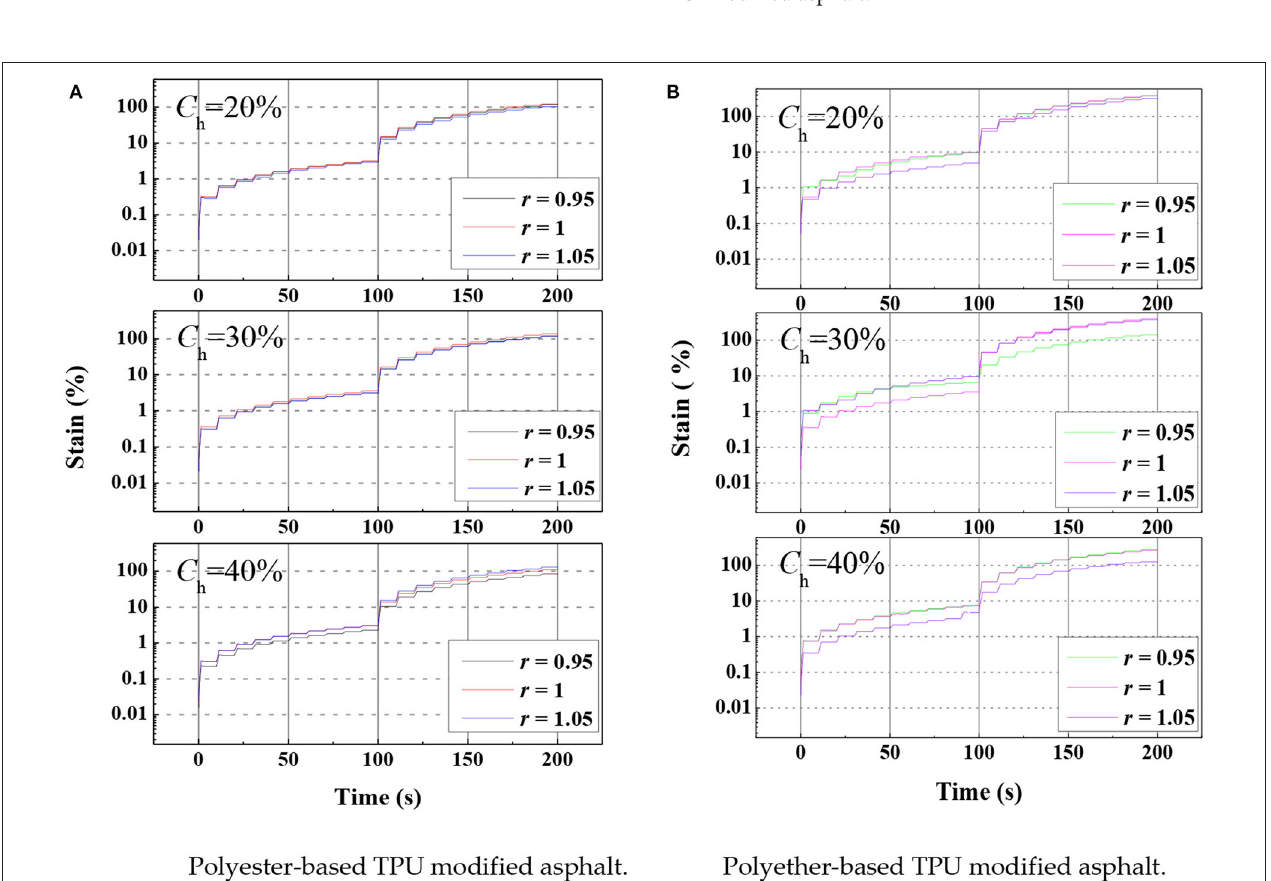
FIGURE 31 | Time-irreversible strain curves at 64 ◦ C. (A) Polyester-based TPU-modified asphalt. (B) Polyether-based TPU-modified asphalt.